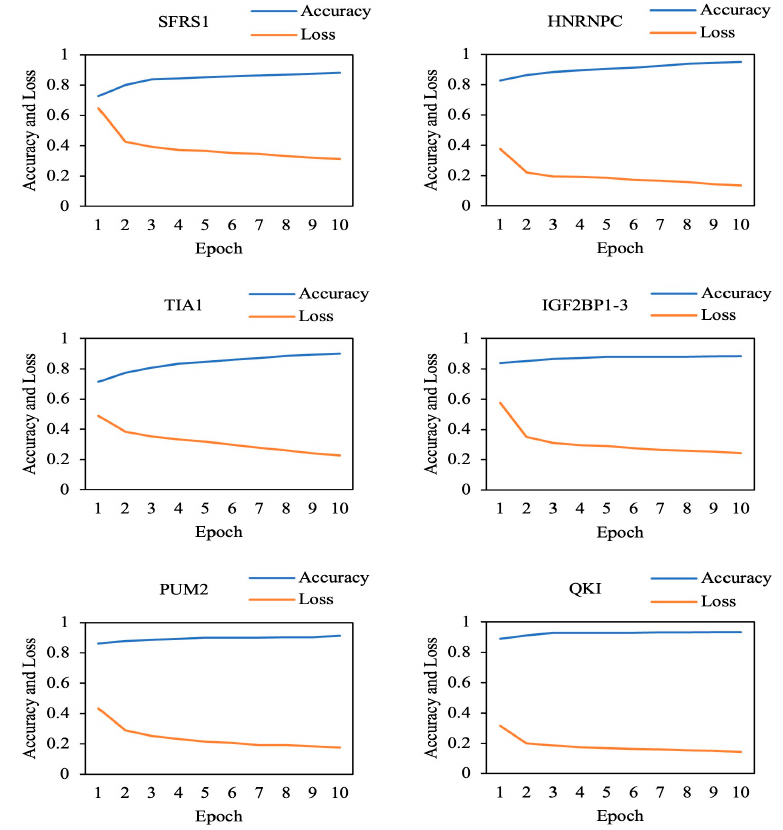
Figure 5. The accuracy and loss training processes for SFRS1, HNRNPC, TIA1, IGF2BP1-3, PUM2, and QKI.